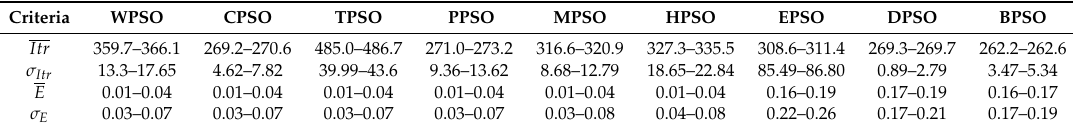
Figure 7. Impacts of D and e on localization performance of CPSO. ( a ) E ; ( b ) σ E ; ( c ) Itr ; ( d ) σ Itr . Table 5. Variation range of different D > 0 and e >